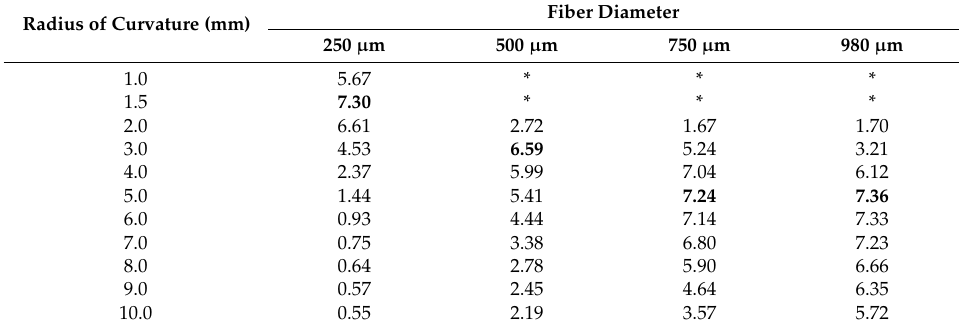
Table 1. Simulation of the sensitivity of sensors (dP/dn) in the measurement of refractive indices for several diameters and radius of curvature. Bold numbers indicate the best sensitivity for each fiber